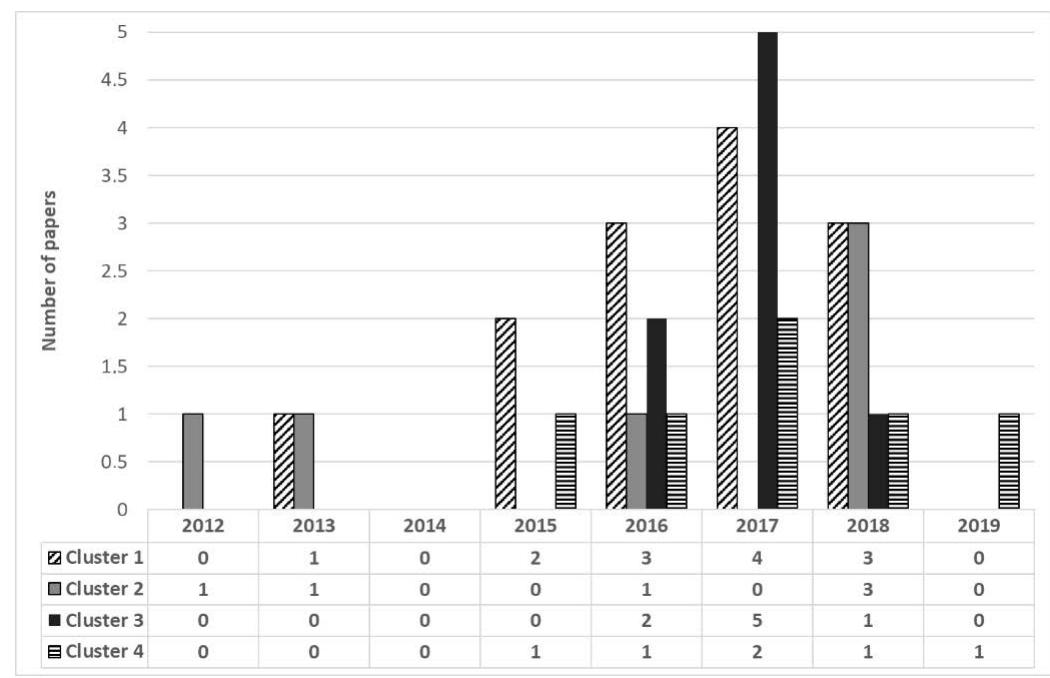
Figure 5. Distribution of papers across clusters over